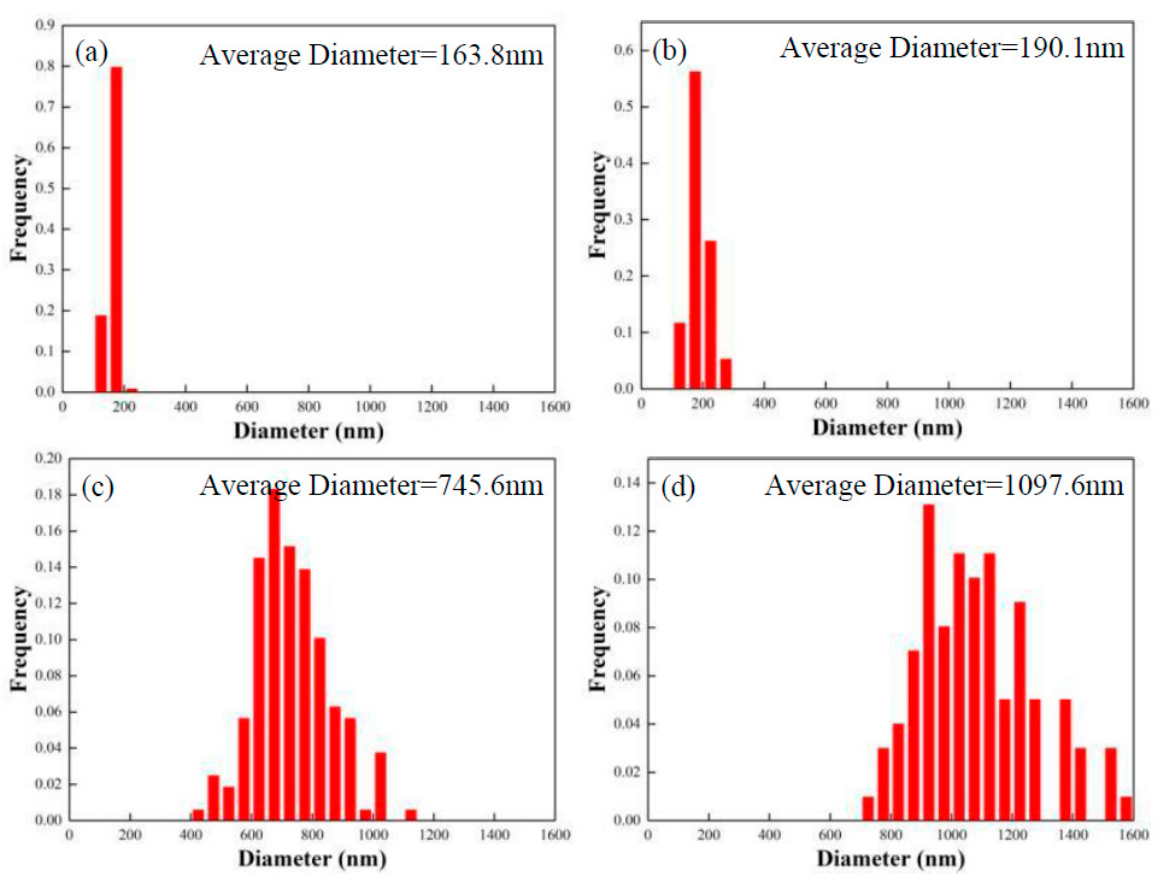
Figure 4. The particle size distribution of the primary γ′ precipitates under different cooling rates: ( a ) 10 °C/min, ( b ) 5 °C/min, ( c ) 1 °C/min, ( d ) 0.25 °C/min.